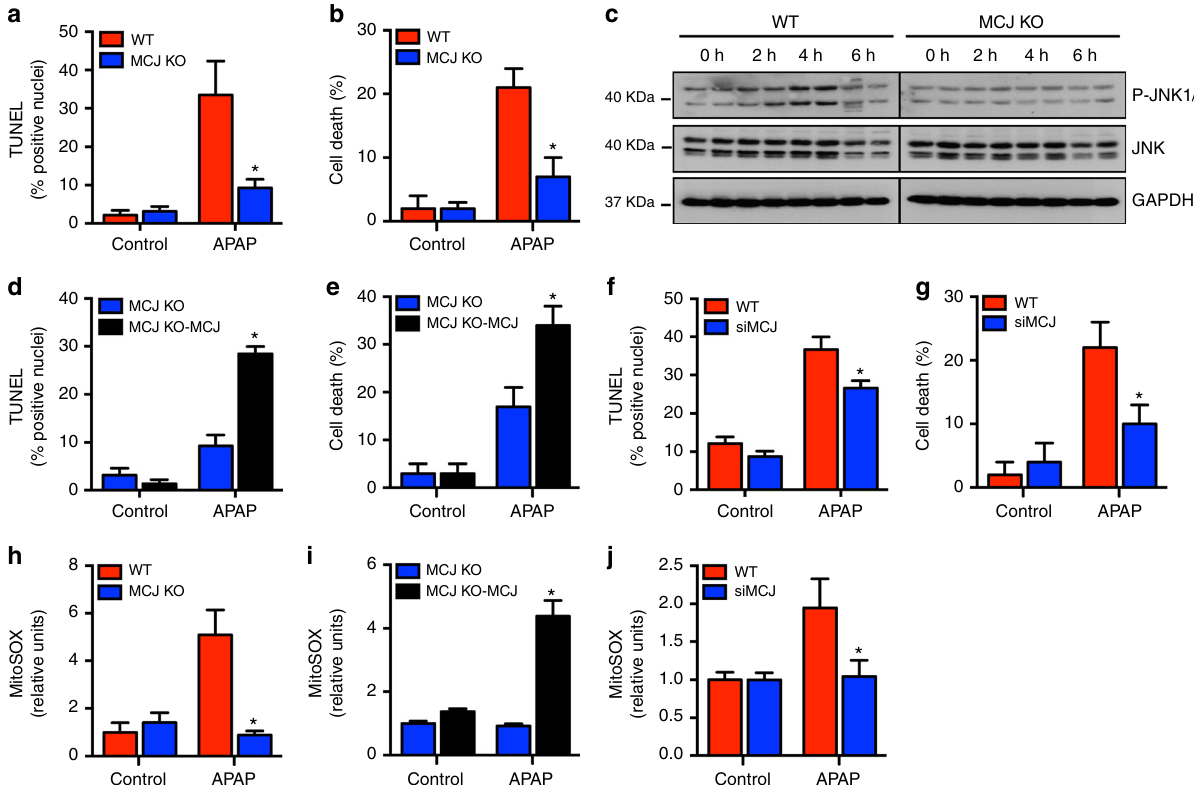
Fig. 1 MCJ expression determines the susceptibility of hepatocytes to APAP toxicity. a , b Cell death in WT and MCJ KO hepatocytes using TUNEL assay ( a ) and Trypan blue staining ( b ) after treatment with APAP for 9 and 6 h, respectively. c JNK activation was evaluated by western blotting in WT and MCJ KO hepatocytes after APAP exposure. d , e Cell death in MCJ KO hepatocytes and MCJ KO hepatocytes transfected with MCJ (MCJ KO-MCJ) using TUNEL assay ( d ) and Trypan blue staining ( e ) after treatment with APAP for 9 and 6 h, respectively. f , g Cell death in WT hepatocytes and WT hepatocytes transfected with siMCJ (siMCJ) using TUNEL assay ( f ) and Trypan blue staining ( g ) after treatment with APAP for 9 and 6 h, respectively. h – j Mitochondrial ROS in WT and MCJ KO hepatocytes ( h ), MCJ KO hepatocytes, and MCJ KO hepatocytes transfected with MCJ ( i ), WT hepatocytes, and WT hepatocytes transfected with siMCJ ( j ) MCJ KO-MCJ upon 6 h of APAP treatment using MitoSOX staining. Values are represented as mean ± SEM. * P < 0.05 (Student ’ s t test) (MCJ KO vs. WT, MCJ KO-MCJ vs. MCJ KO, and siMCJ vs. WT). Triplicates were used for experimental